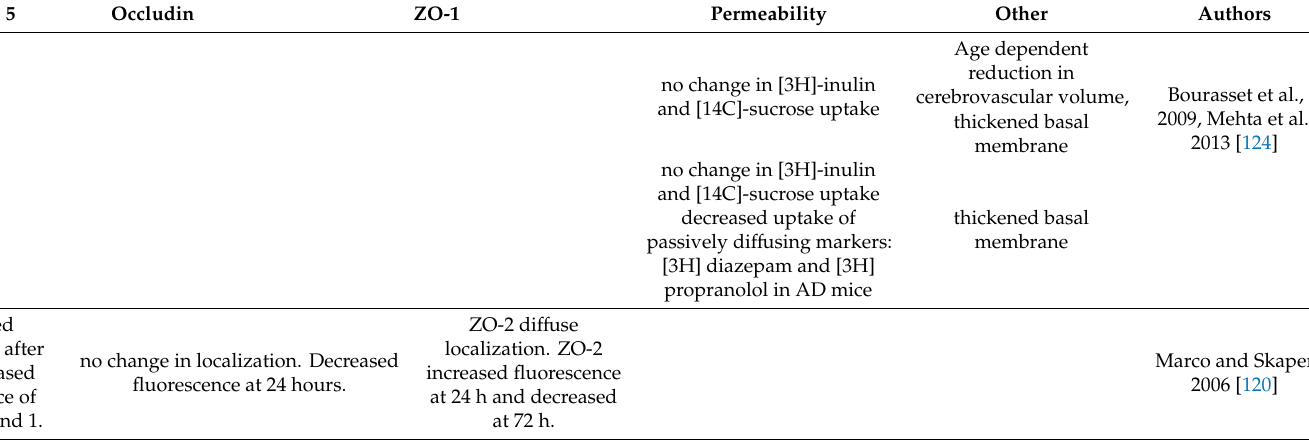
Table 3. BBB function and junctional proteins in age related disorders, neurodegenerative